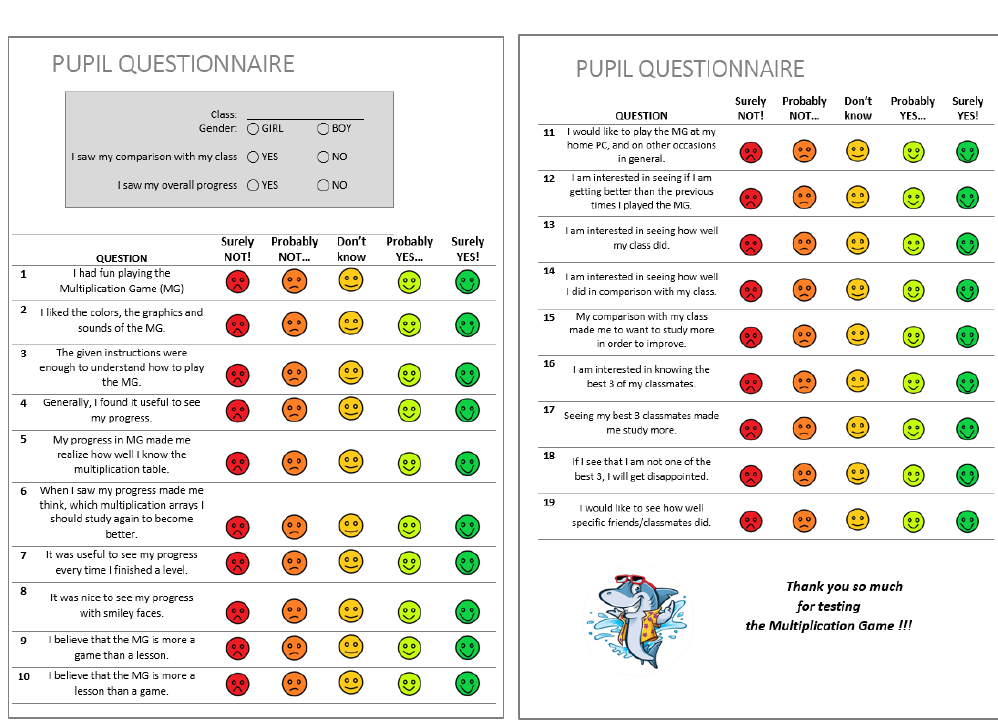
Figure 6. Questionnaire used for assessing MG v.3 486